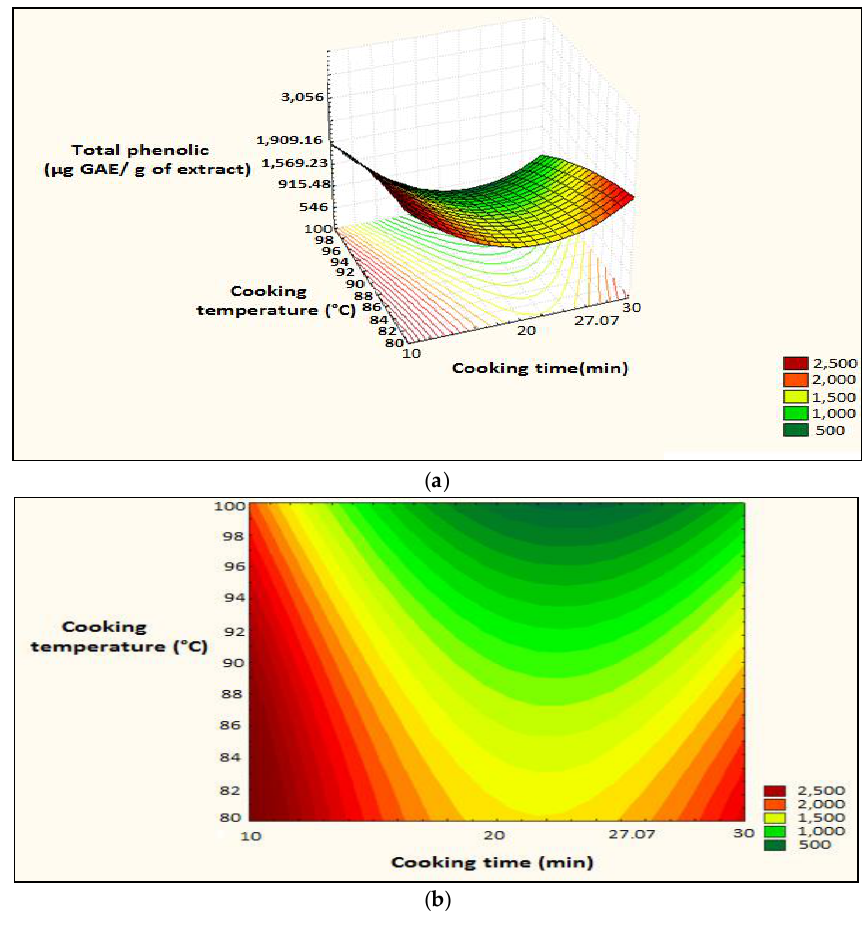
Figure 9. Surface plot and iso-response curve of polyphenols as a function of both time and temperature cooking factors, ( a ): surface plot; ( b ): iso-response curve. The optimum conditions for achieving the best polyphenol content are: time: 10 min and temperature: 80 °C, and predicted polyphenol content is 3356.08 GAE/g of extract (Figure 10).